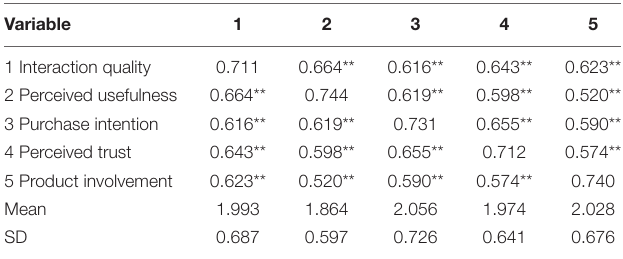
TABLE 2 | Descriptive statistics correlation coefficients and discriminant validity model.